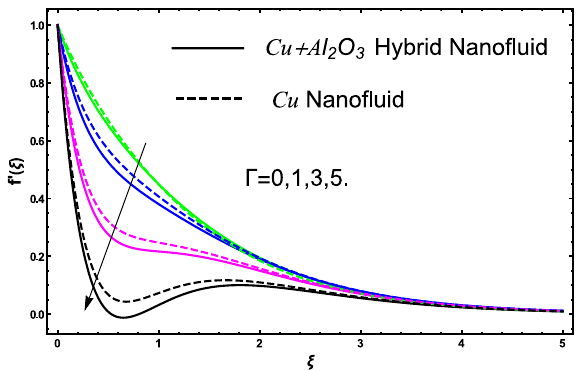
′ (ξ) profile against escalating values of Ŵ .